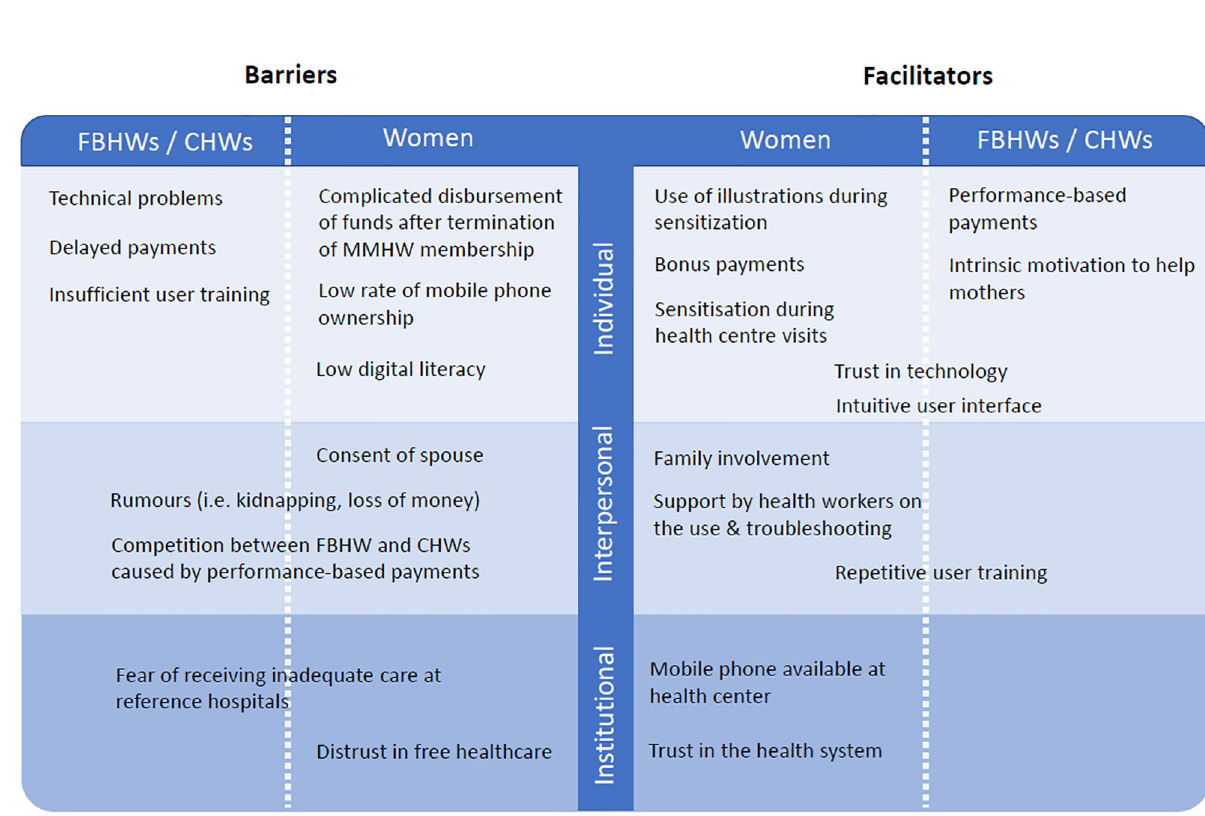
Fig 3. Institutional, interpersonal, and individual level factors influencing the usability and acceptance of the Mobile Maternal Health Wallet among women, facility- (FBHWs) and- community-based (CHWs) health workers.